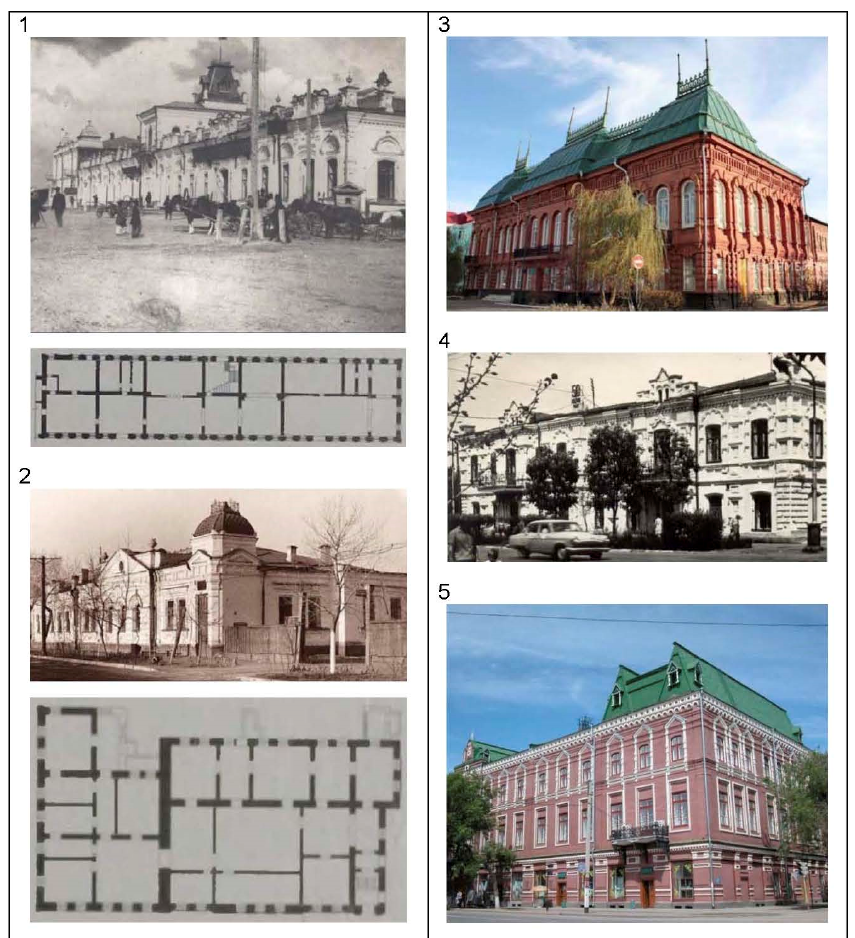
Figure 2. Business centers of Kazakhstan in the second half of the 19th to the early 20th century: ( 1 ) The DEROV’S HOUSE, Pavlodar, 1896 [69]; ( 2 ) The OKHAPKIN’S HOUSE, Pavlodar, 1908 [70]; ( 3 ) The VANYUSHIN’S HOUSE, Uralsk, 1870 [71]; ( 4 ) The ARKEL’S HOUSE, Petropavlovsk, 1891 [72]; and ( 5 ) KARAEV’S HOUSE, Ural’sk, 1900